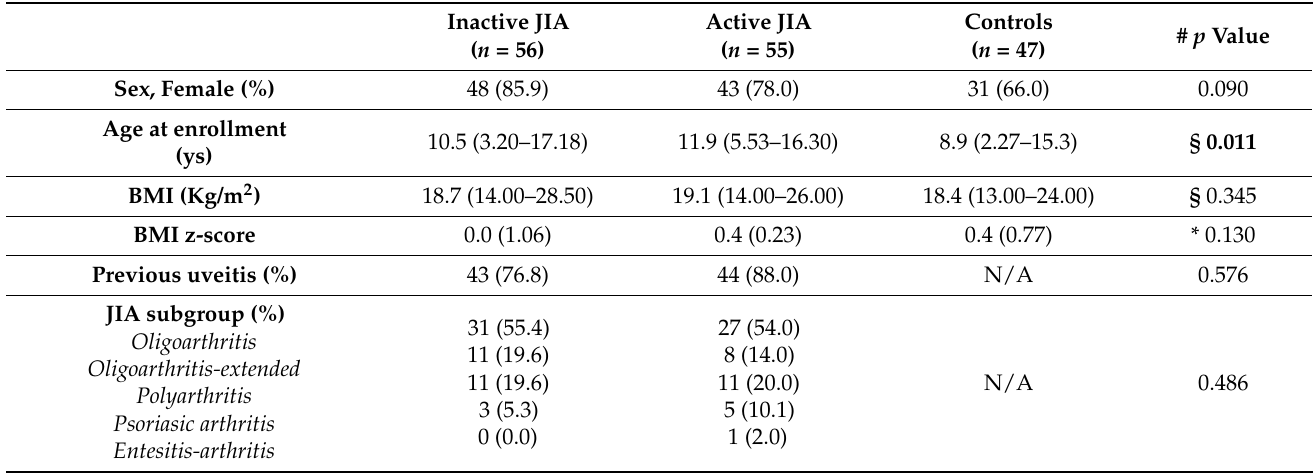
Table 1. Demographic, clinical and laboratory data of the study population.